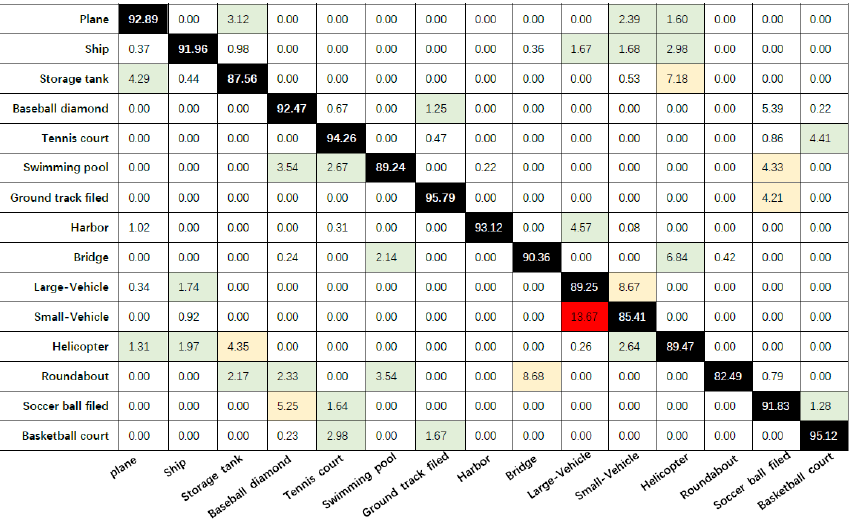
Figure 10. Confusion matrix for the methods in this